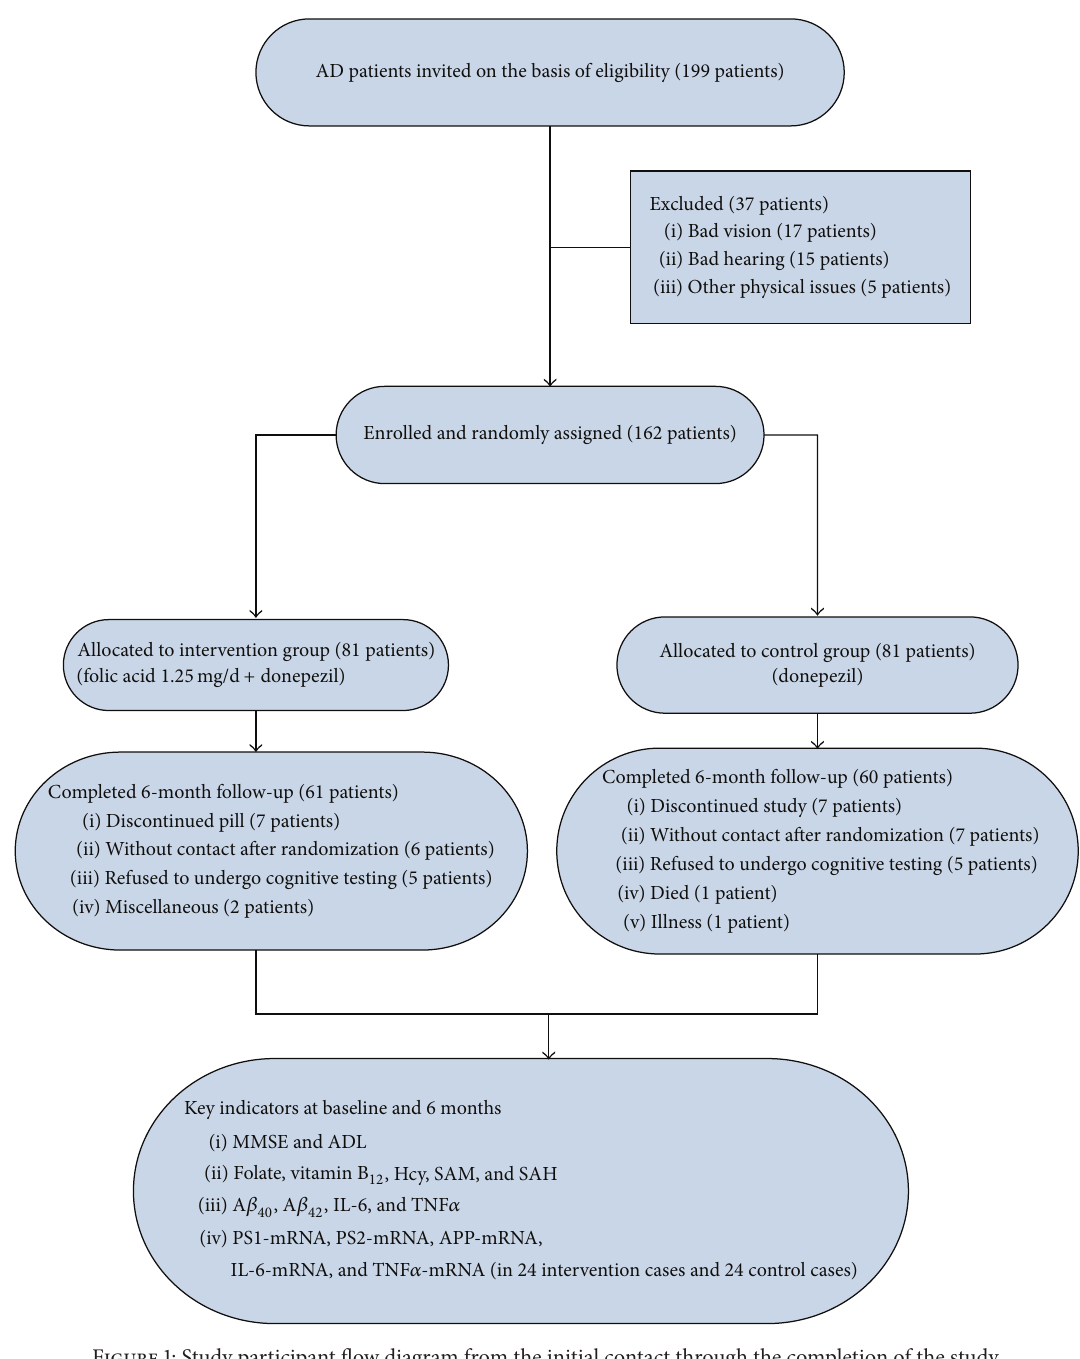
Figure 1: Study participant flow diagram from the initial contact through the completion of the study.